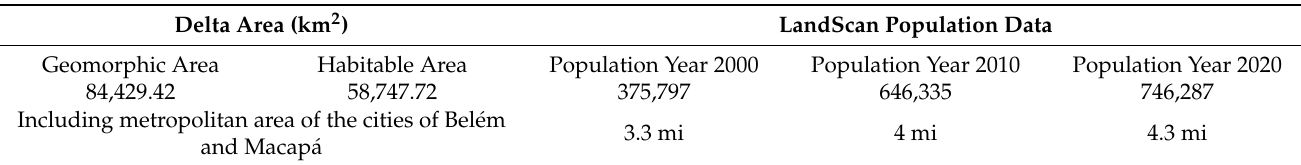
Table 1. Geomorphic area (defined as both land and water), habitable area (land area), and population increases in the Amazon delta [8], and 2020 population density [11,12].